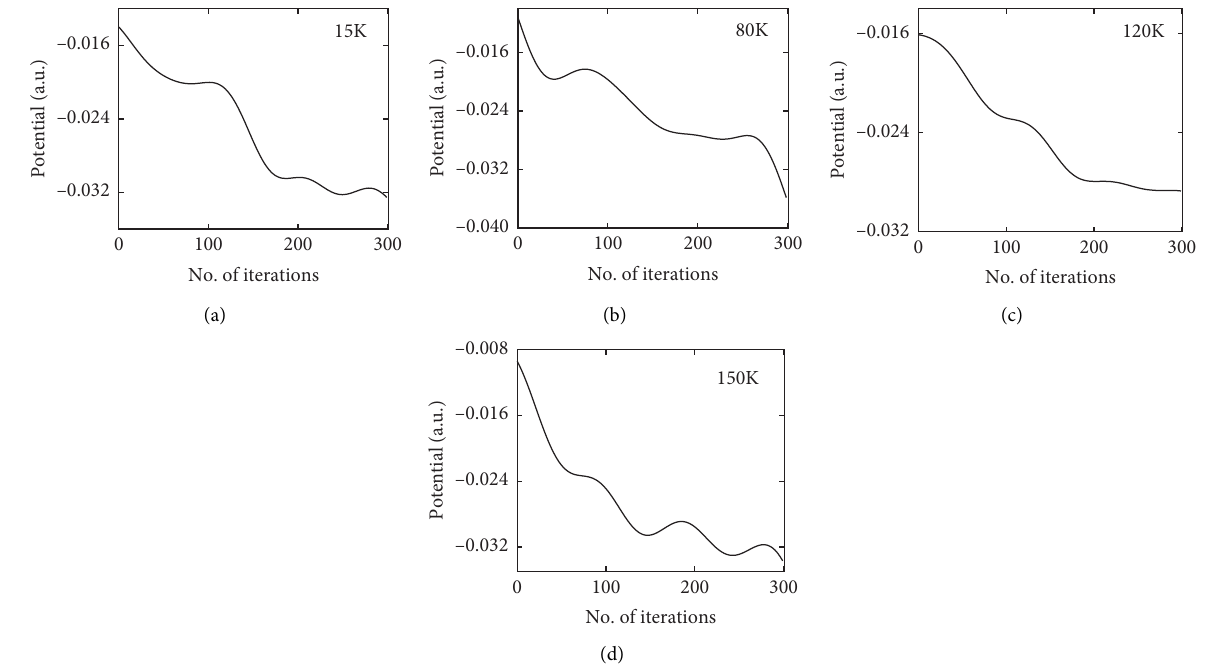
Figure 6: Convergence behavior of hybrid of adiabatic quantum annealing simulator with Metropolis-adjusted stochastic gradient Langevin dynamics; the expectation potential value for operator U zz is simulated at four typical temperatures: 15K, 80K, 120K, and